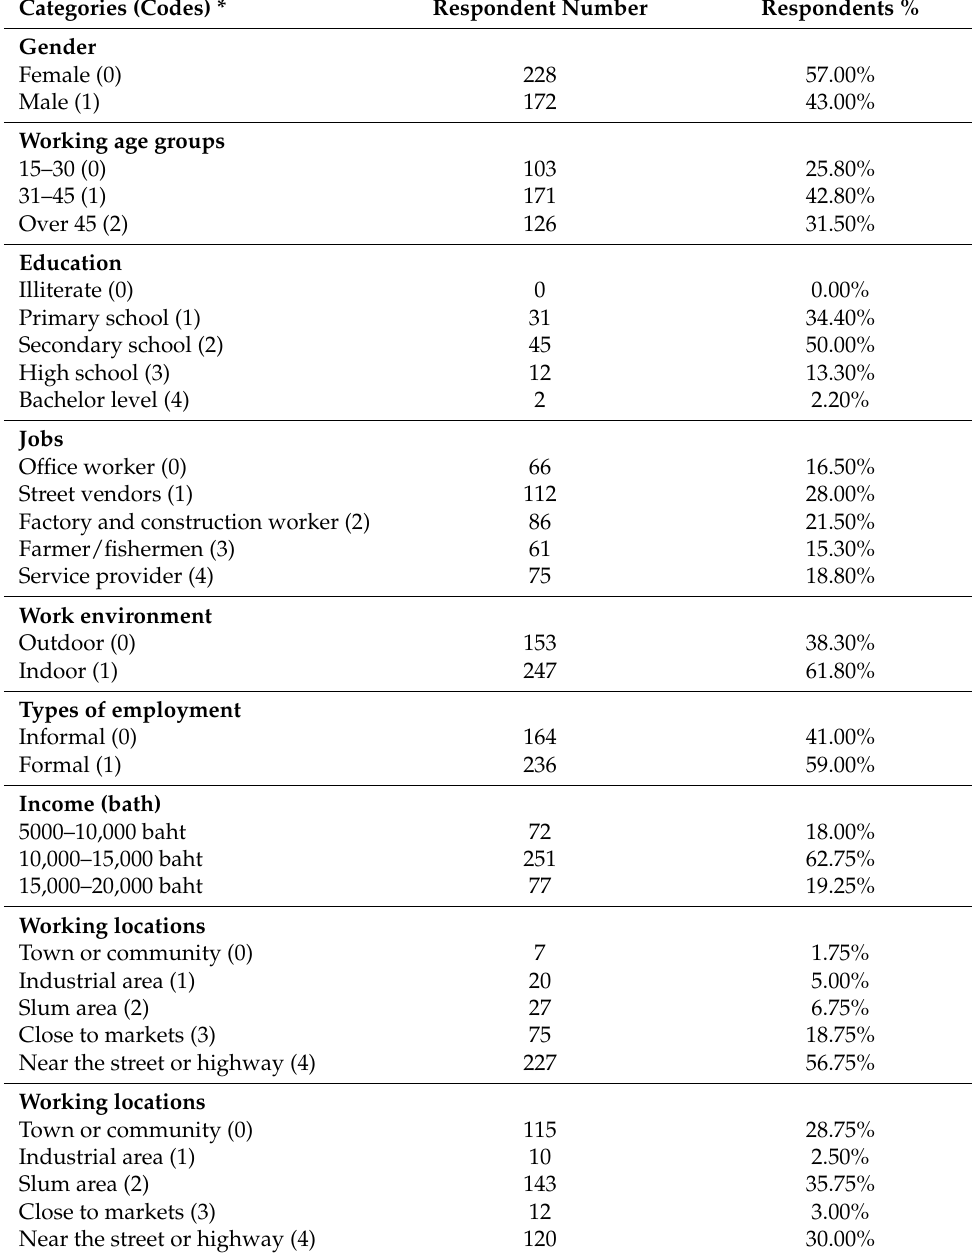
Table 1. Socio-economic and demographic characteristics of surveyed respondents (N =